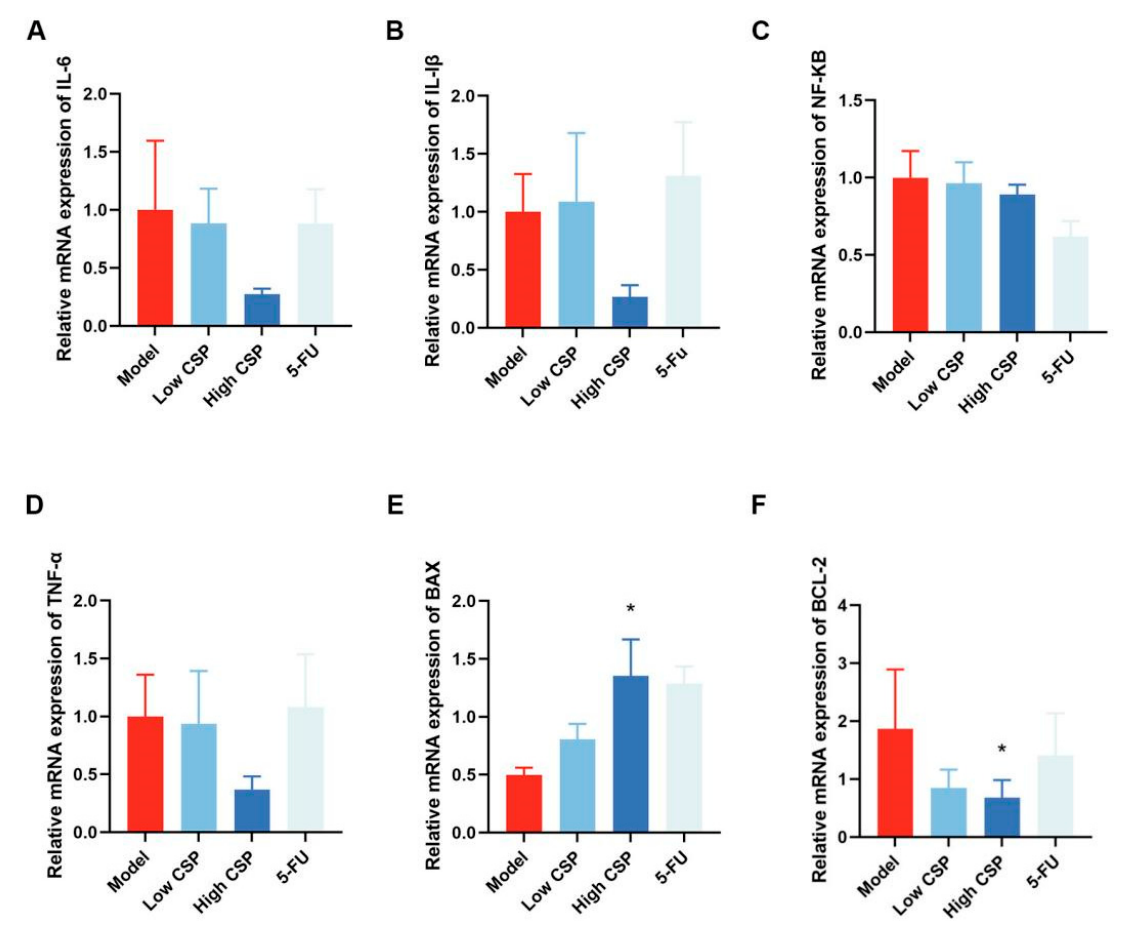
Figure 7. WCP promotes Cyto-c/Caspase8/3 and inhibits IL-10/STAT3/Bcl2 pathway. ( A – F ) Relative mRNA expression of IL-6, IL-I β , NF- κ B, TNF- α , Bax, and Bcl2. * p < 0.05 compared to model group.